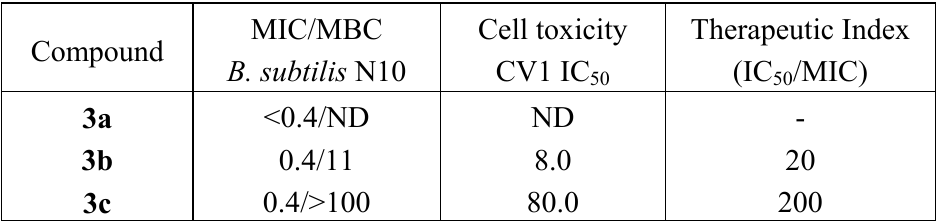
Table 1. Antimicrobial Screening